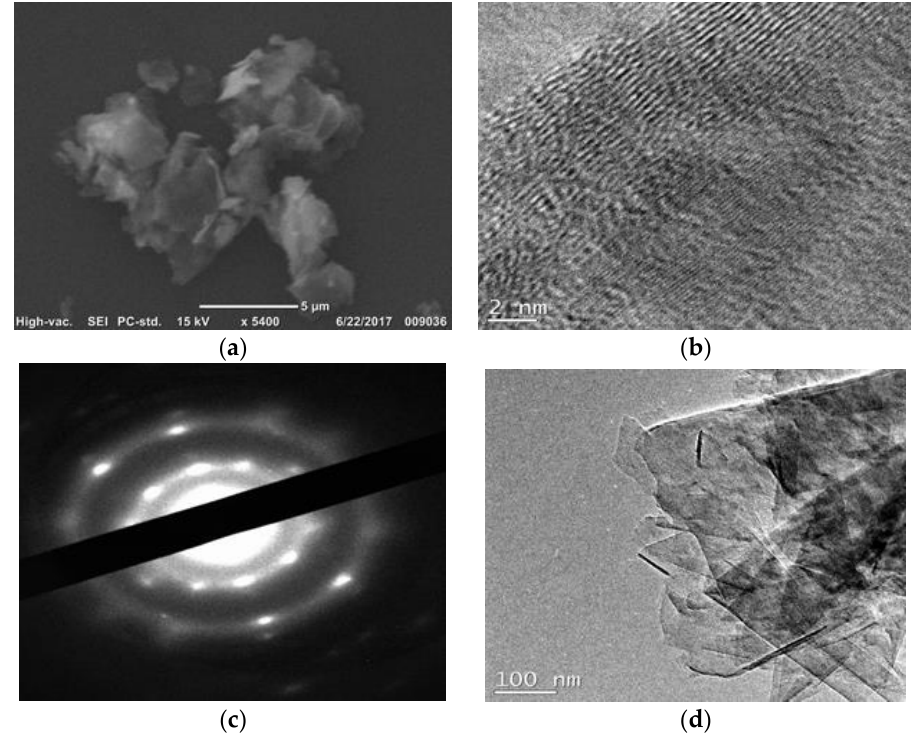
Figure 4. High-resolution Scanning Electron Microscope (SEM) and Transmission Electron Microscopy (TEM) images of our fabricated product: ( a ) high-resolution SEM image of GNS, ( b ) high-resolution TEM image of GNS, ( c ) electron diffraction pattern of GNS, and ( d ) low-resolution TEM image of GNS.